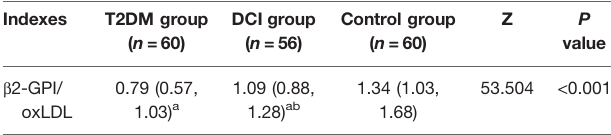
TABLE 2 | Comparison of clinical data in three groups x + s.